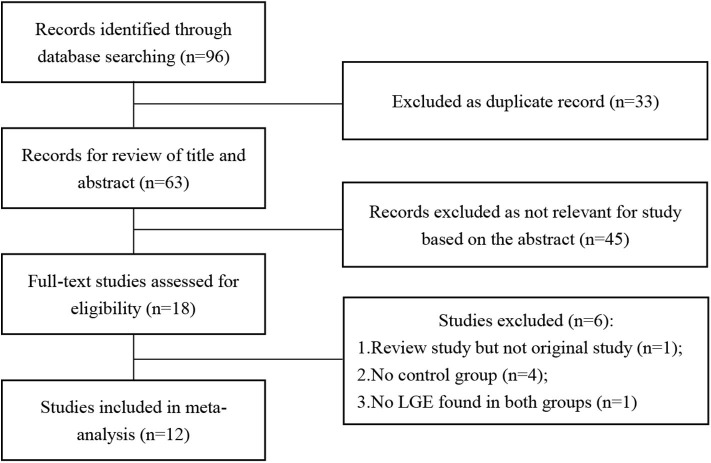
Flow chart of literature selection.